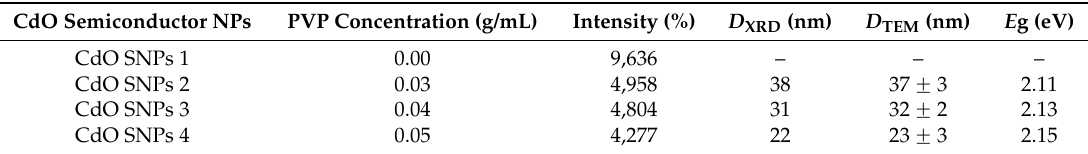
Table 1. Summary of the structural and optical properties of synthesized CdO nanoparticles at PVP different